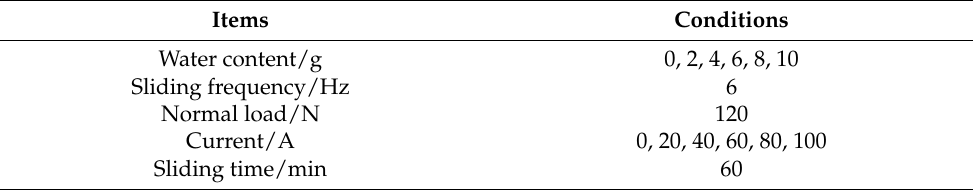
Table 2. Parameters of the